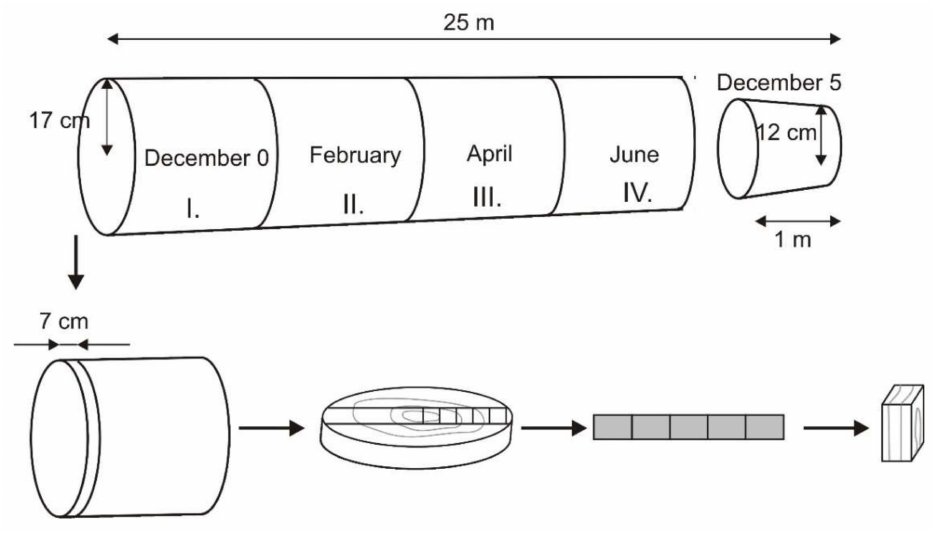
Figure 1. Scheme of test figure